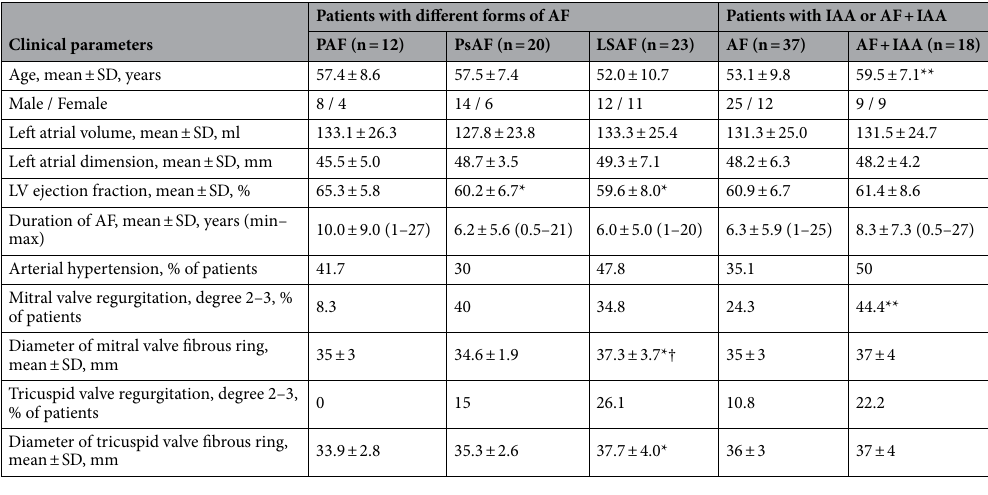
Table. 2.. Clinical characteristics of patients with different forms of AF (PAF, PsAF, LSAF) and two groups with AF and AF + IAA. *Comparison with PAF, Mann–Whitney U Test p < 0.05. † Comparison with